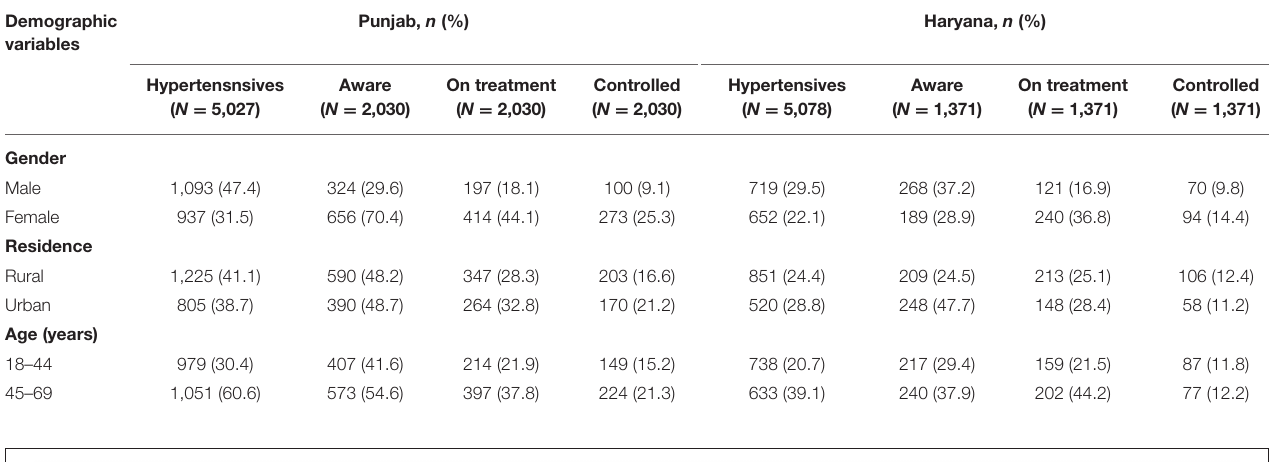
TABLE 2 | Proportion (%) of hypertension awareness, treatment, and control in Punjab and Haryana, India. Demographic variables